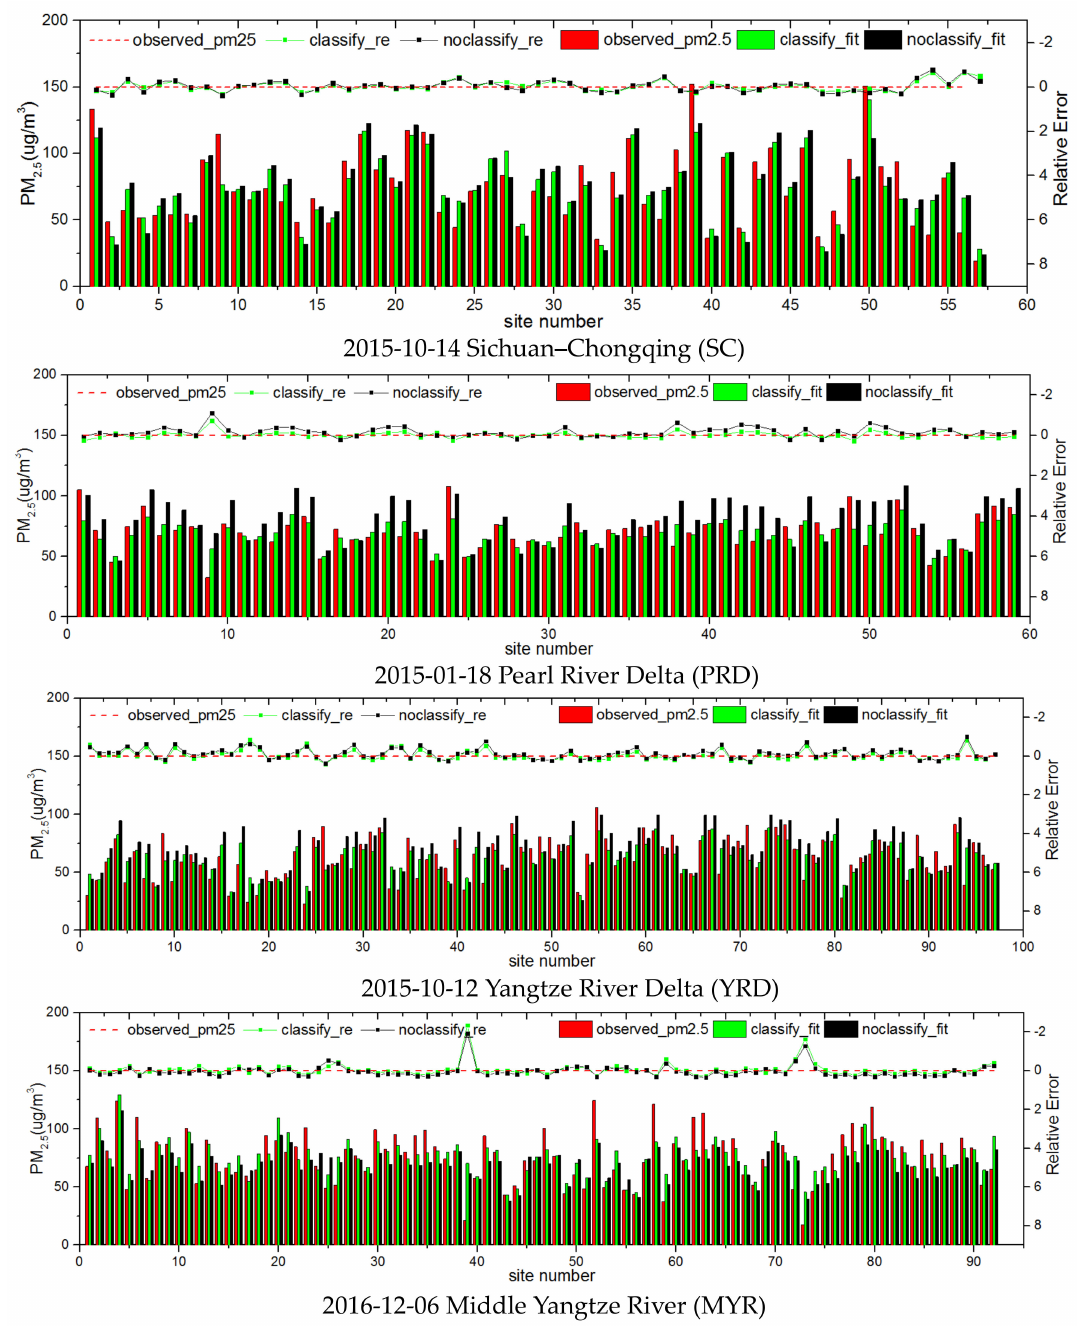
Figure 4. The relative error (RE) in the PM 2.5 concentrations for the ground-measured and satellite retrieval result using the classified and unclassified aerosol type methods in Beijing–Tianjin–Hebei (BTH), Sichuan–Chongqing (SC), Pearl River Delta (PRD), Yangtze River Delta (YRD), and Middle Yangtze River (MYR). The red dashed, green solid, and dark lines are the RE values calculated via ground-measured, classified, and unclassified methods. The red, green, and dark rectangles are the PM 2.5 obtained using the ground-measured, classified, and unclassified methods,